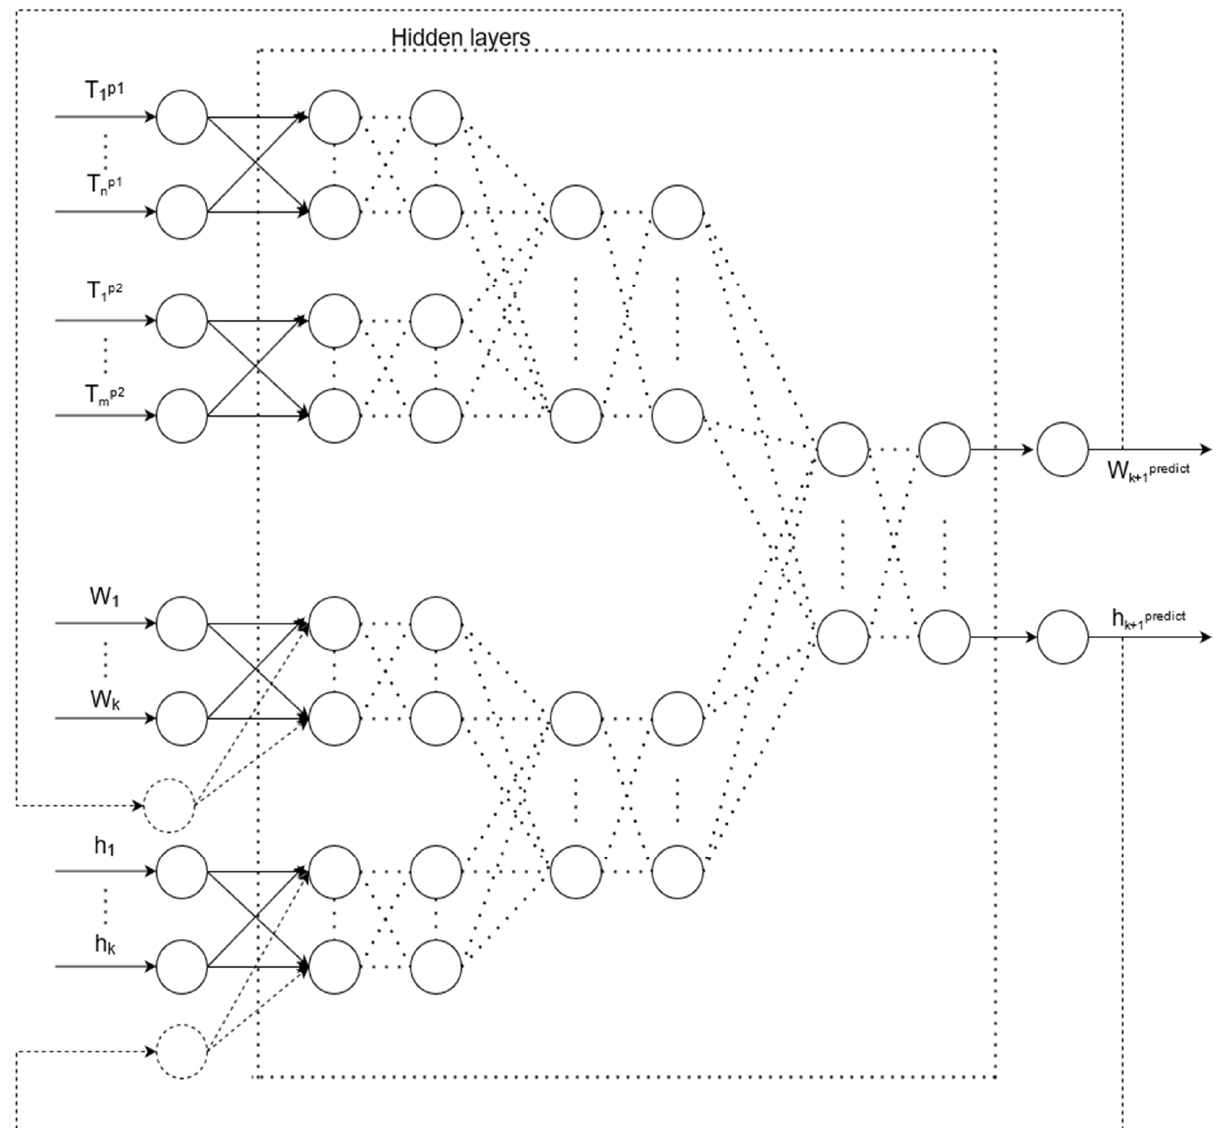
Figure 9. Artificial neural network structure for predicting measurements, where T 1p1 , ..., T np1 are input data representing time-series measurements of the first pyrometer, T 1p2 , ..., T mp2 are input data representing time-series measurements of the second pyrometer, h 1 , ..., h k are input data representing the time series of values of the distance from the inductor to the assembly of the waveguide path, W 1 , ..., W k are input data, which are the time series of power settings, h k+1 are the output of ANN, which is the calculated value of the distance from the inductor to the workpiece, and W k+1 are the output of ANN, which is the calculated value of the inductor power